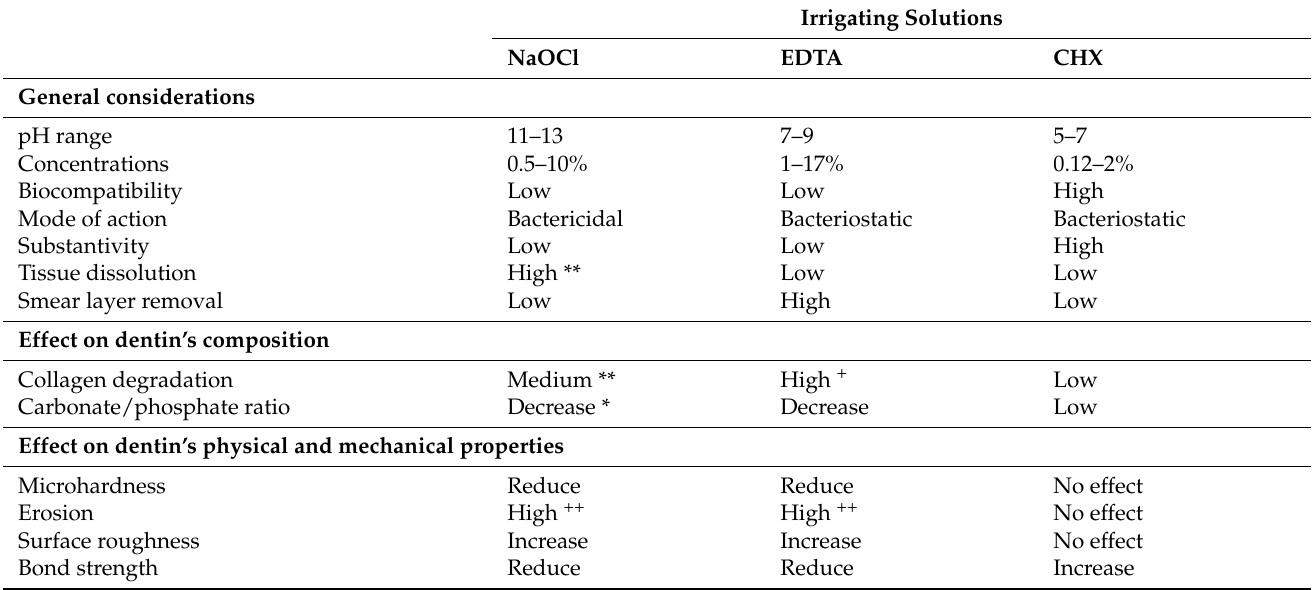
Table 1. Summary of each endodontic irrigating solutions and their reported effects on the physical and mechanical properties of dentine